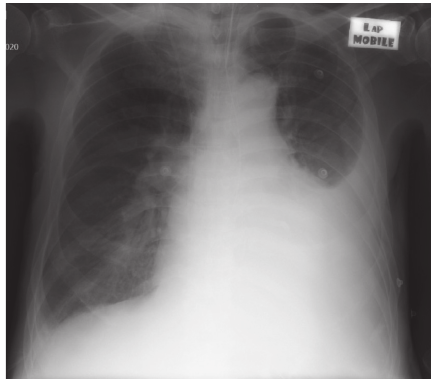
Figure 1: Left medium abundance pleural